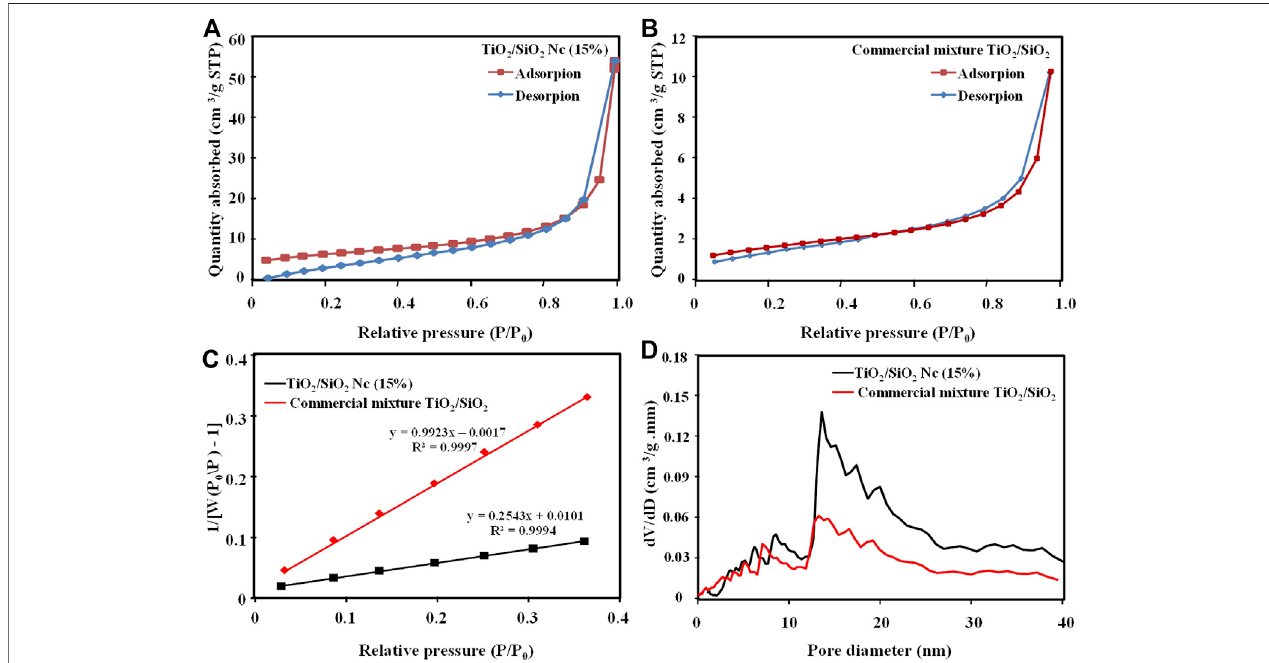
FIGURE 5 | Nitrogen adsorption isotherm pattern of TiO 2 /SiO 2 Nc (15%) (A) and commercial mixture TiO 2 /SiO 2 (B) , BET plot of TiO 2 /SiO 2 Nc (15%) and commercial mixture TiO 2 /SiO 2 (C) , and BJH pore size distribution (D)